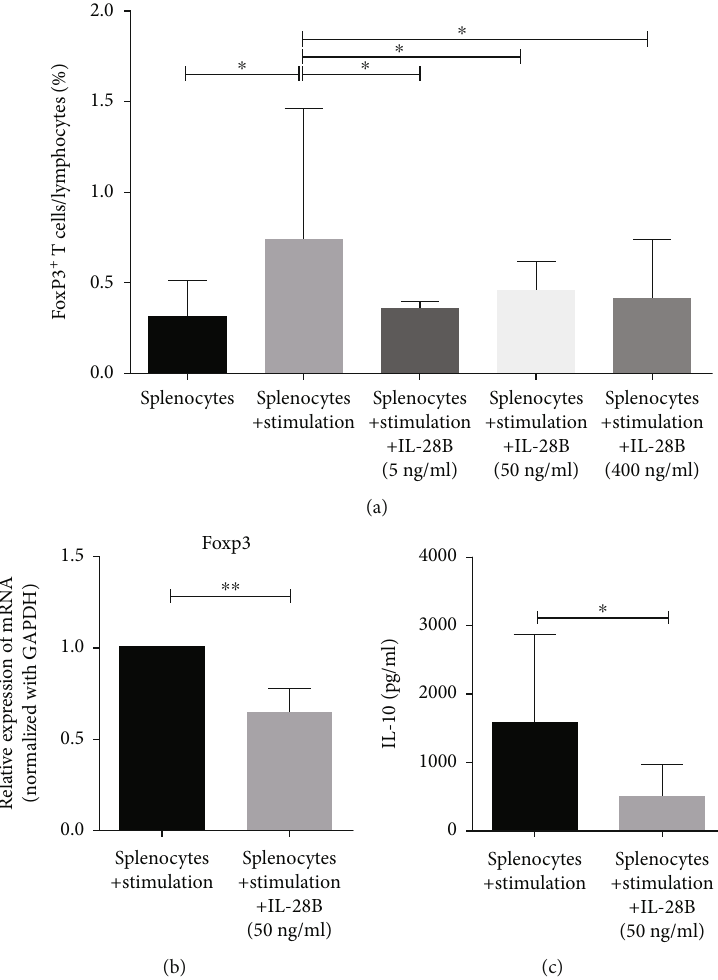
Figure 5: IL-28B inhibited the proportion of Foxp3 + -producing cells in a dose-dependent manner concomitant with a reduction in IL-10 production and Foxp3 mRNA expression. Splenocytes isolated from normal BALB/C mice were stimulated with anti-CD3/CD28 mAbs supplemented with IL-2 in the presence of TGF- β ± IL-28B (5, 50, and 400 ng/ml). Splenocytes cultured in complete RPMI 1640 medium were used as the control. Cells stimulated with 500 ng/ml anti-CD3/CD28 mAbs, 5 ng/ml IL-2, and 1.25ng/ml TGF- β were de fi ned as the stimulation group. After three days, cells were harvested for fl ow cytometry and RT-PCR analysis, and cell-free culture was collected for IL-10 assay. (a) The percentages of Foxp3 + T cells were shown in bar graphs. Data were from six independent experiments. (b, c) The Foxp3 mRNA expression and IL-10 level were shown. Data from one experiment, each performed with three samples, are shown. ∗ P < 0 : 05 ; ∗∗ P < 0 : 01